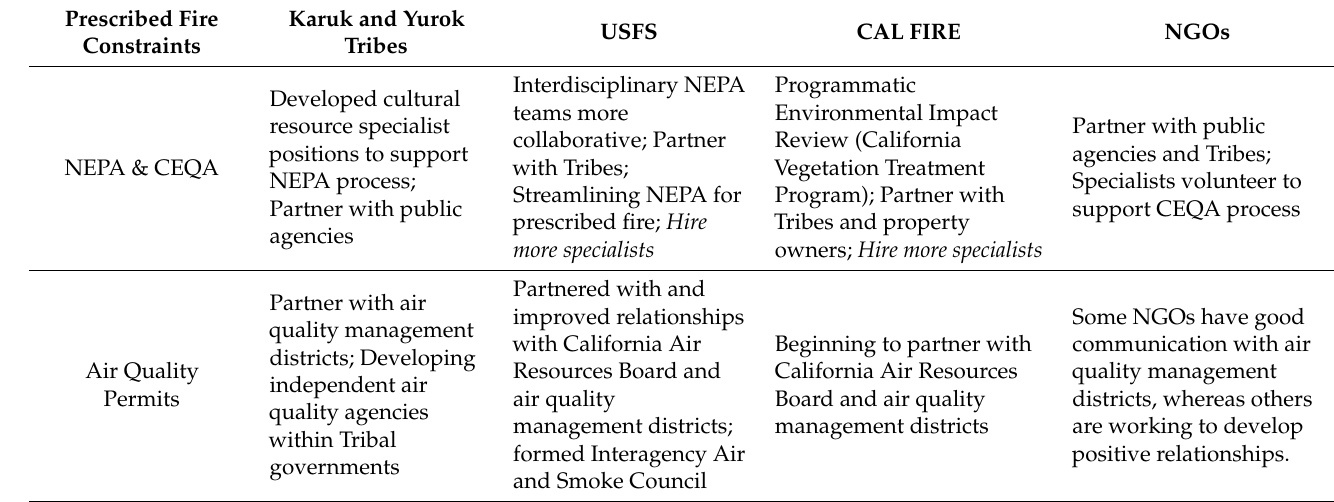
Figure 7. Effective Actions That Increased Prescribed Burning in Northern California. Fire managers were asked to identify the top three actions they took to increase prescribed burning in their agency, organization, or Tribe. Their responses were not weighted and were totaled. Table 1. Actions taken or proposed by Tribes, Unites States Forest Service (USFS), CAL FIRE and Non-Governmental Organizations (NGOs) to alleviate prescribed fire constraints in northern California. Actions summarized from surveys and interviews with 75 fire managers, and from participant observations (2015–2019). Actions Taken or Proposed ( in italics ) to Alleviate Constraint by